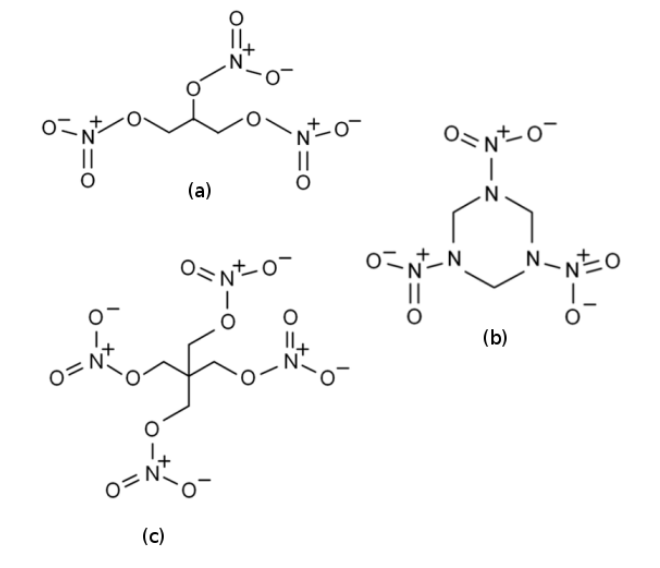
FIGURE 10 . Explosive chemical structures: (a) NG, (b) RDX, (c)